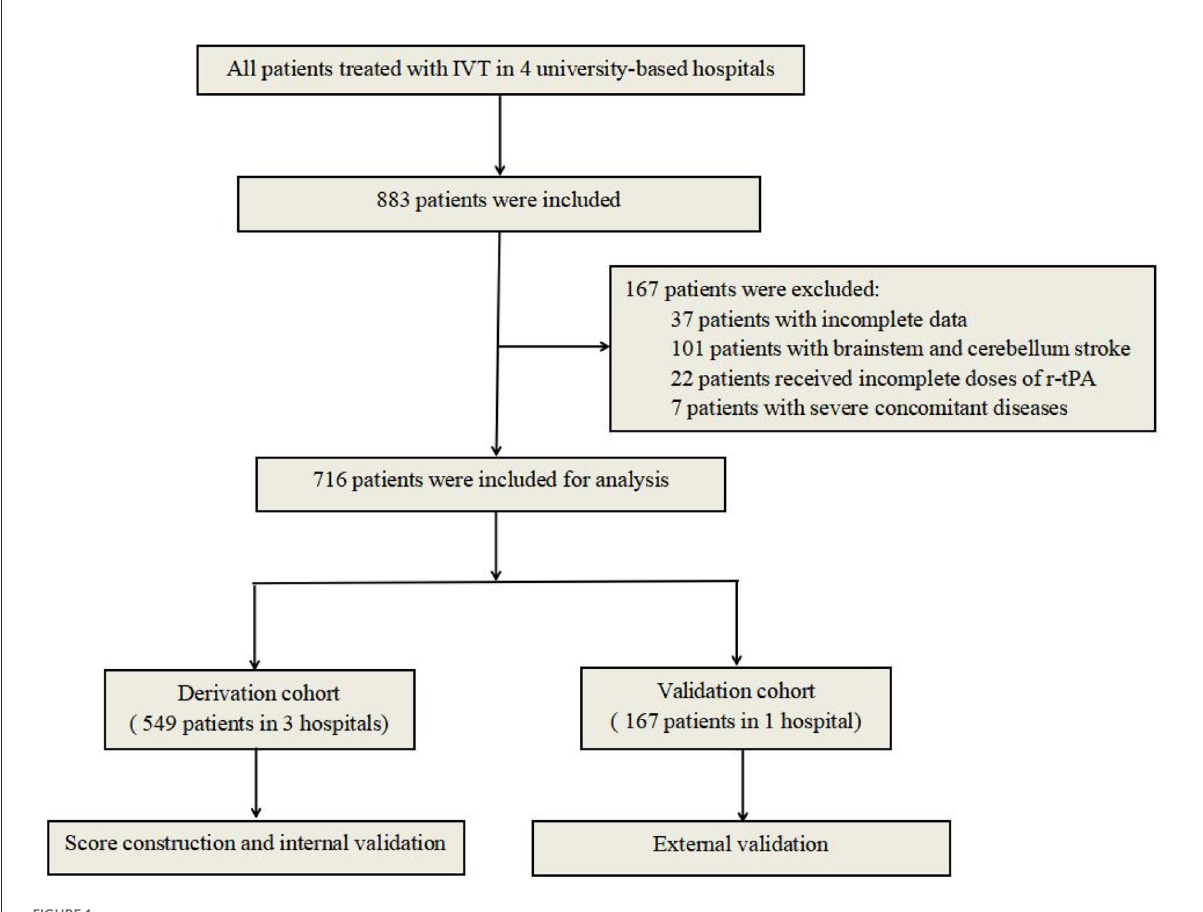
FIGURE1 Flowchart of our study.